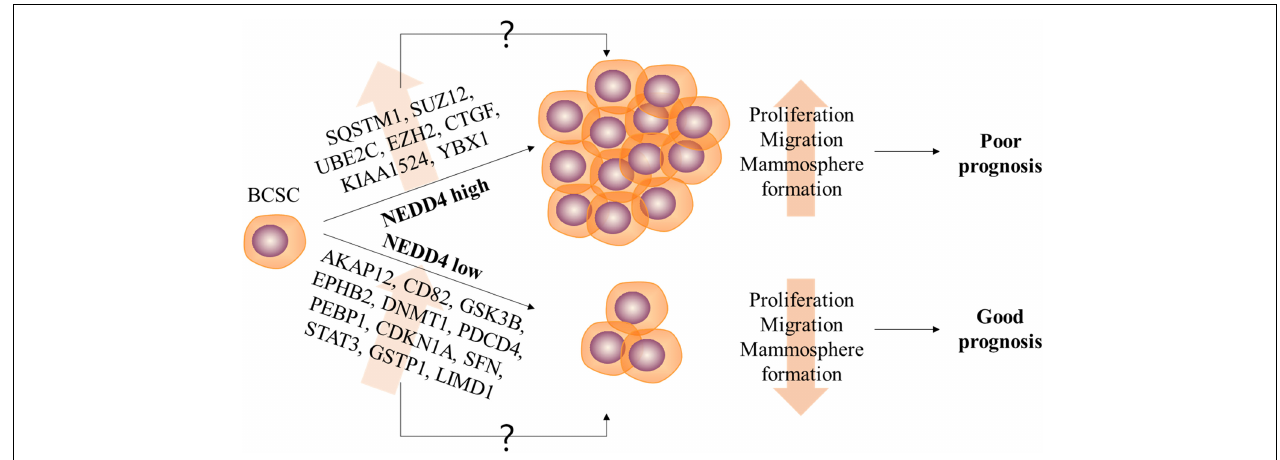
FIGURE 6 | The role of NEDD4 in the regulation of breast cancer stem cell (BCSC) properties in MDA-MB-231. The schematic model shows that NEDD4 is required for proliferation, migration, and stemness maintenance in BCSCs. The breast cancer patients with a high expression of NEDD4 in BCSCs may show a shorter survival period and a poor prognosis due to the increased proliferation, migration, and stemness of BCSCs, while the patients with a low level of NEDD4 in BCSCs may live longer and have a better prognosis. Although detailed researches were needed, our proteomics analysis revealed that the differentially expressed proteins by NEDD4 knockdown were related to